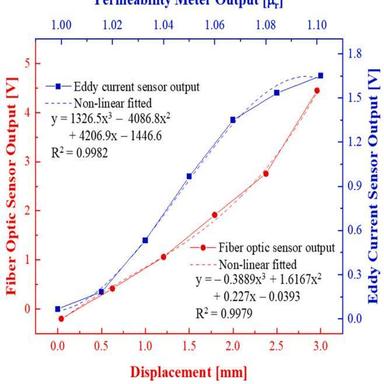
Calibration curves of the fiber optic eddy current sensor.